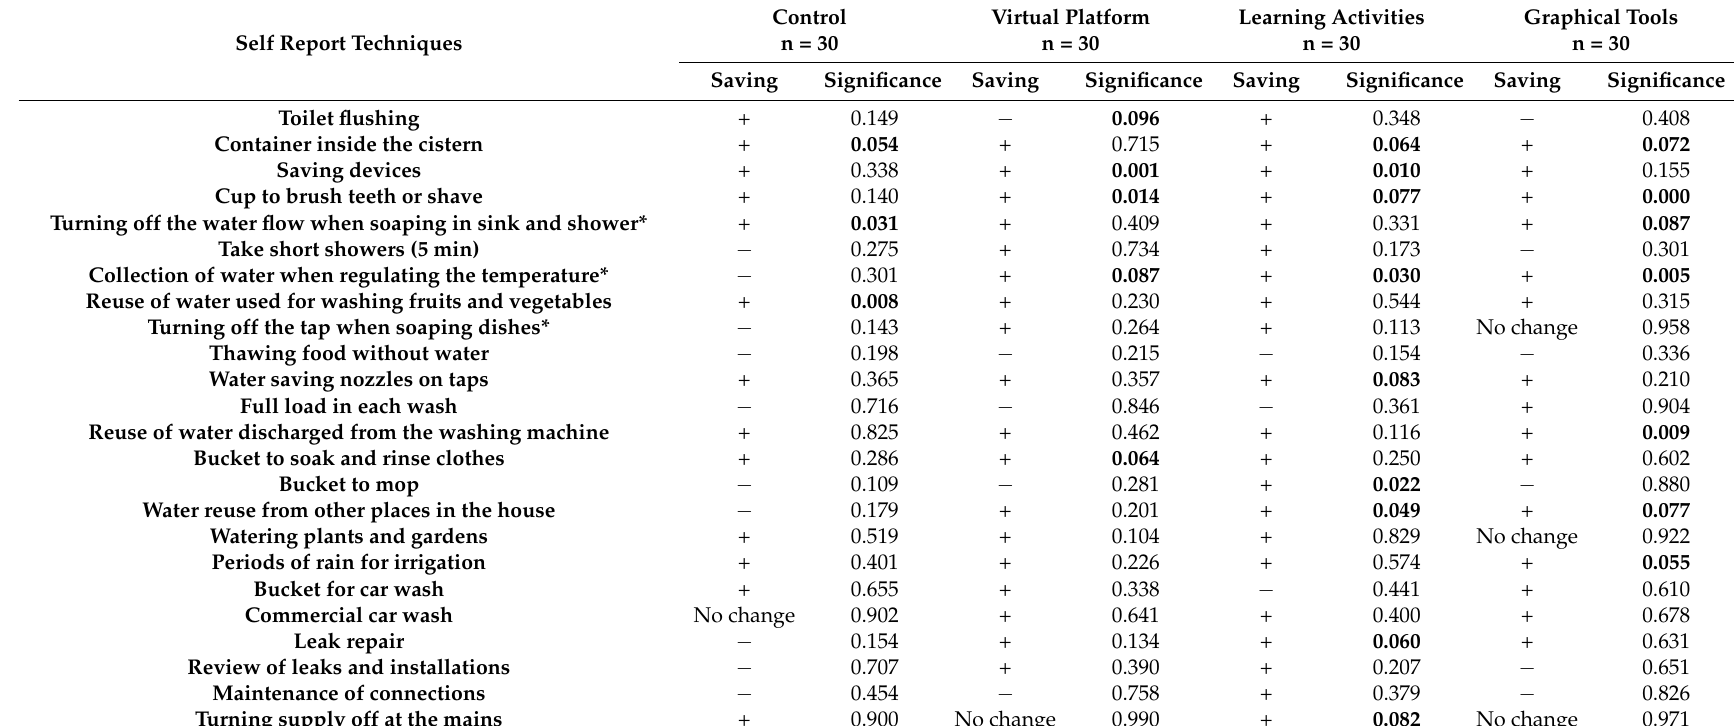
Table 3. Comparison of effects in self-report